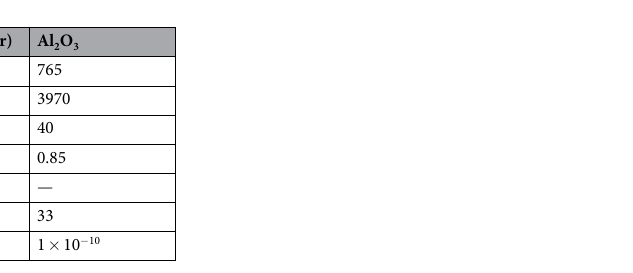
Table 2. Thermo-physical properties of water with Al 2 O 3 nanoparticles at T = 310 K 20,48 .